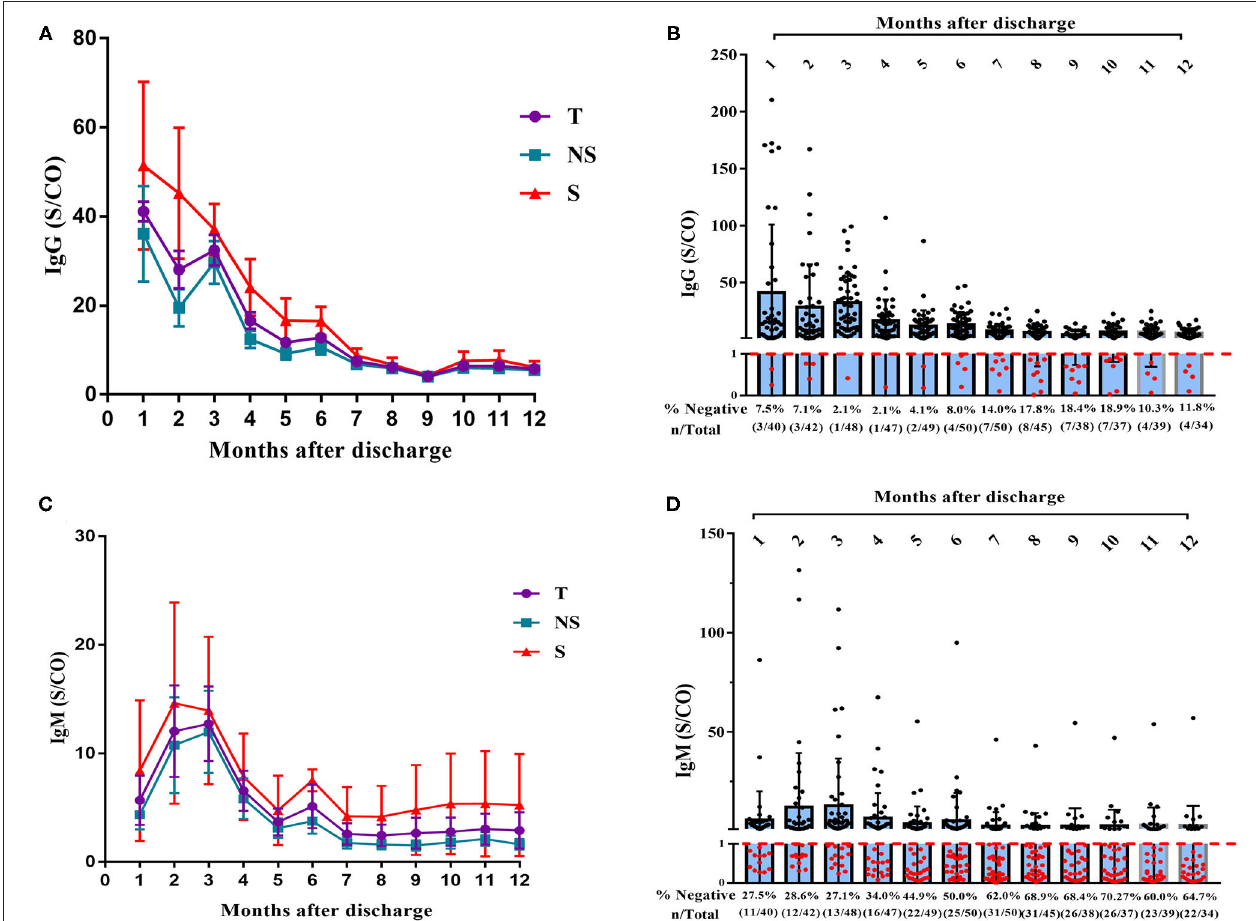
FIGURE 1 | Dynamic changes of IgG and IgM titer over time in 51 patients with COVID-19. (A) Dynamic changes of IgG levels in patients with COVID-19 after 12 months’ follow-up. (B) Negative rate of IgG in COVID-19 patients at each time point with 12 months’ follow-up (C) Dynamic changes of IgM levels in patients with COVID after 12 months’ follow-up. (D) Negative rate of IgM in COVID-19 patients at each time point with 12 months’ follow-up. T, total; NS, non-severe; S,